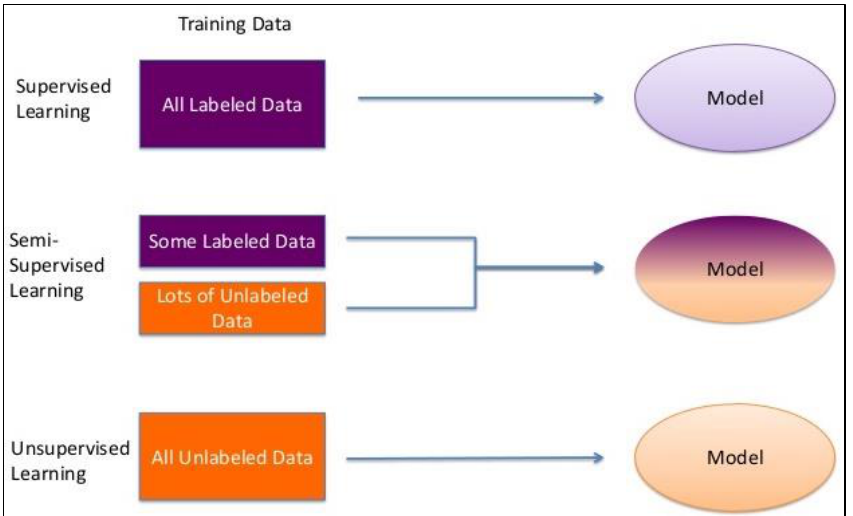
Figure 3: Diagram of the semi-supervised learning